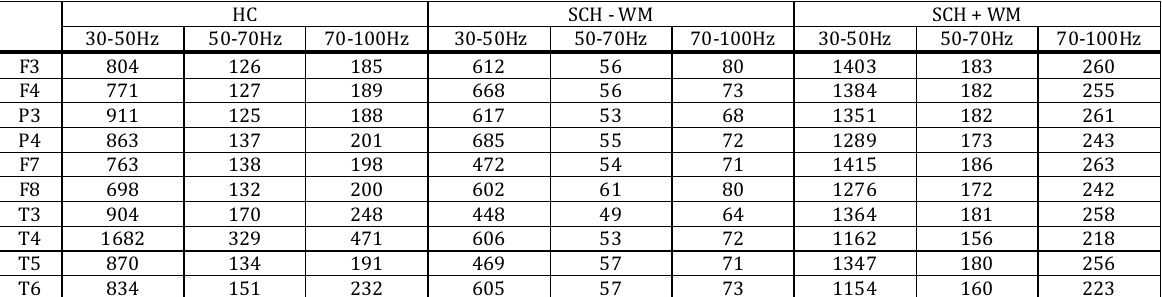
Tab.2 The table contains energy values for single EEG channels obtained by MP algorithm. Three main rows for three subjects (HC, SCH-WM, SCH+WM) shows energy values for three frequency bands 30-50Hz, 50-70Hz and 70-100Hz HC SCH - WM SCH + WM